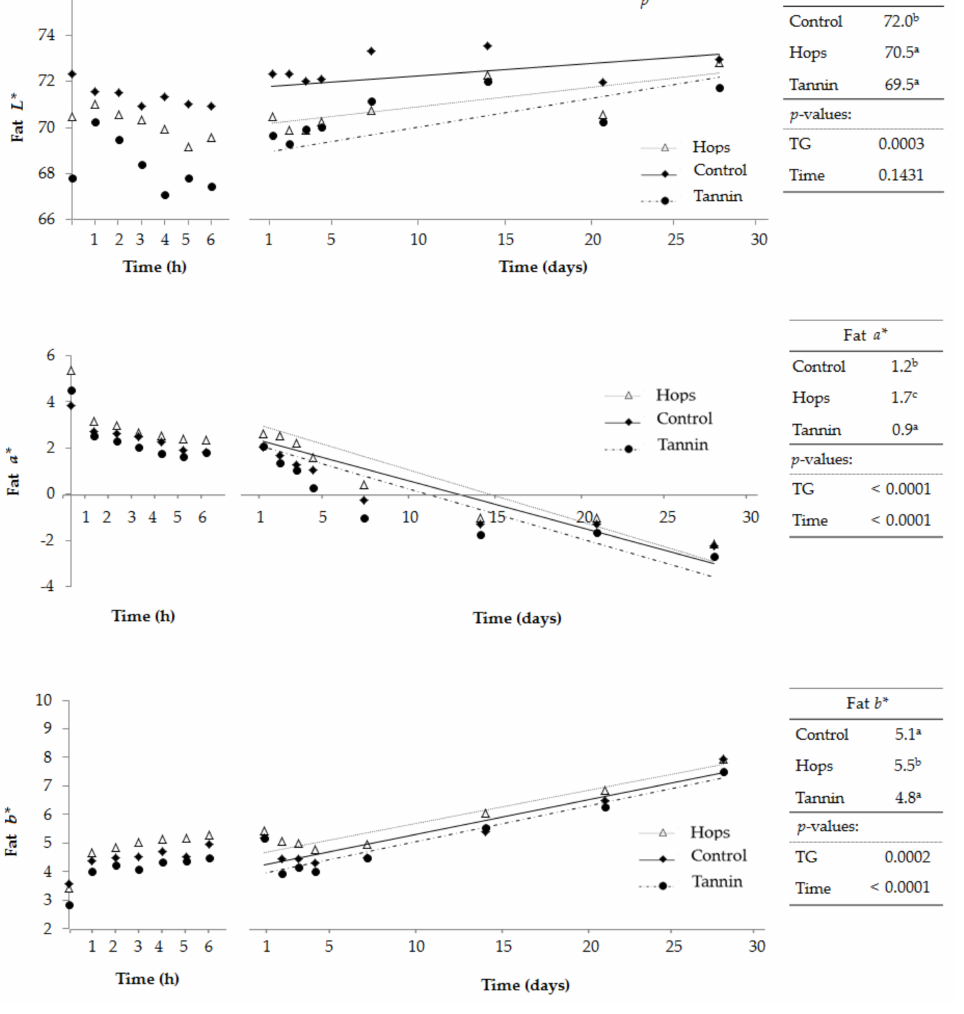
Figure 2. Objective color parameters: CIE lightness: L *, redness: a *, and yellowness: b * of fat of dry-cured bellies during refrigerated storage with lsmeans and p -values for treatment group (TG) and time effects ( abc intercepts ascribed different superscript letters are significantly different at p -value <